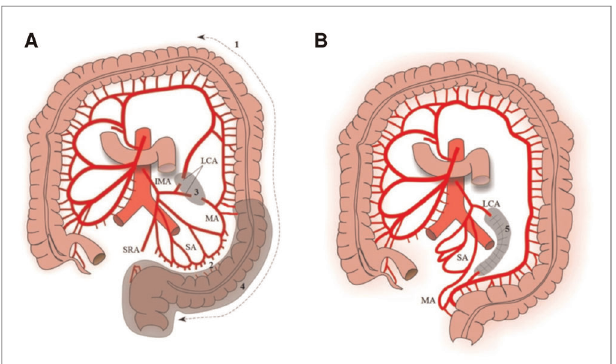
FIGURE 1 | Mobilization of the colon. ( A ) Step 1, mobilization of the splenic fl exure, descending colon, and sigmoid to the recto anal junction; step 2, mobilization of the marginal artery from the sigmoid colon; step 3, LCA division and formation of a “ window ” in the mesentery; step 4, colon pull- through. ( B ) Step 5, the formed mesentery “ window ” is sutured. SA, sigmoid arteries; LCA, left colic artery; IMA, inferior mesenteric artery; MA, marginal artery; SRA, superior rectal